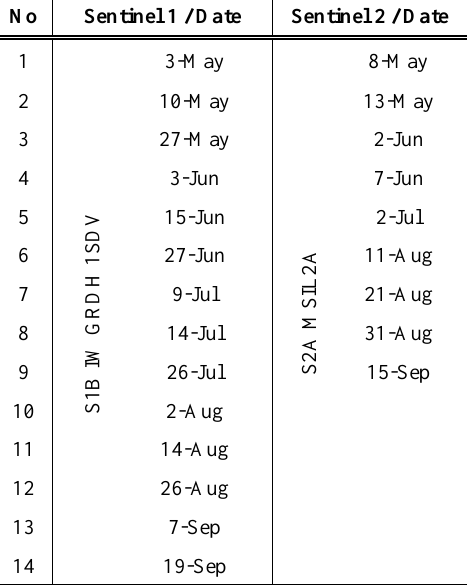
Table 1. Dates of Sentinel-1 and Sentinel-2 data acquisition for